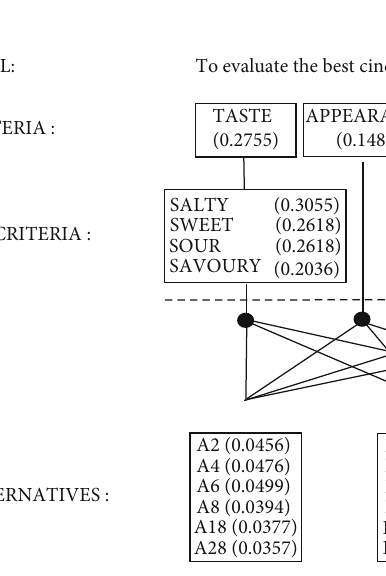
Figure 4: Hierarchy of criteria to evaluate for the consumers ’ acceptability of each recipe. The values presented the score of each criterion and alternatives: (a). recipe A; (b). recipe B; (c). recipe C. The number after the capital letter means incubation time, day. Table 5: The score of each criterion for recipes A, B, and